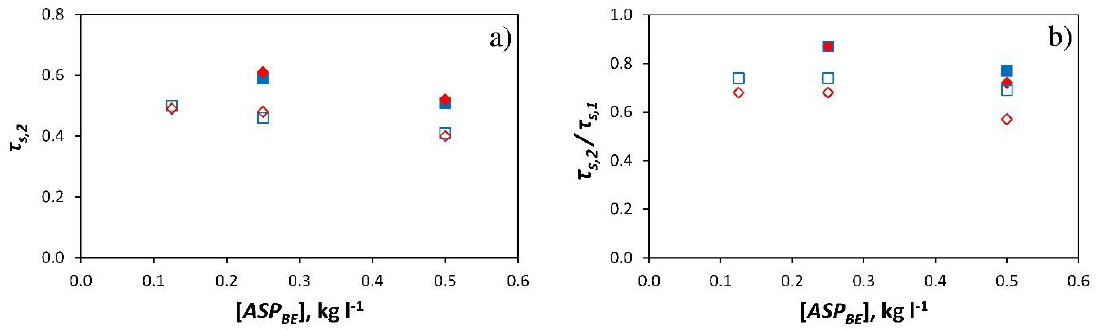
Figure 6. Mean values of solar transmissivity τ s,2 in sector 2 with ASP BE ( a ) and of the ratio τ s,2 / τ s,1 ( b ) for the September-October experiments. [ ASP BE ], concentration in kg l – 1 . Sunny days: □, 10:00 -19:00; ◊, 12:00 -16:00. Cloudy and rainy days: ■ , 10:00-19:00; ♦ , 12:00-16:00. Subscript: 1 , sector 1 (without ASP ); 2 , sector 2 (with ASP ).